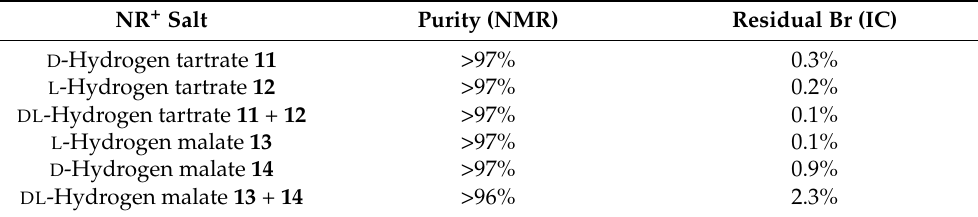
Figure 2. Structural formulas of the crystalline NR + derivatives: nicotinamide- β - D -riboside D -hydrogen tartrate ( 11 ), nicotinamide- β - D -riboside L -hydrogen tartrate ( 12 ), nicotinamide- β - D - riboside L -hydrogen malate ( 13 ), nicotinamide- β - D -riboside D -hydrogen malate ( 14 ). Table 3. Purity and residual bromide of crystalline NR + hydrogen malates and